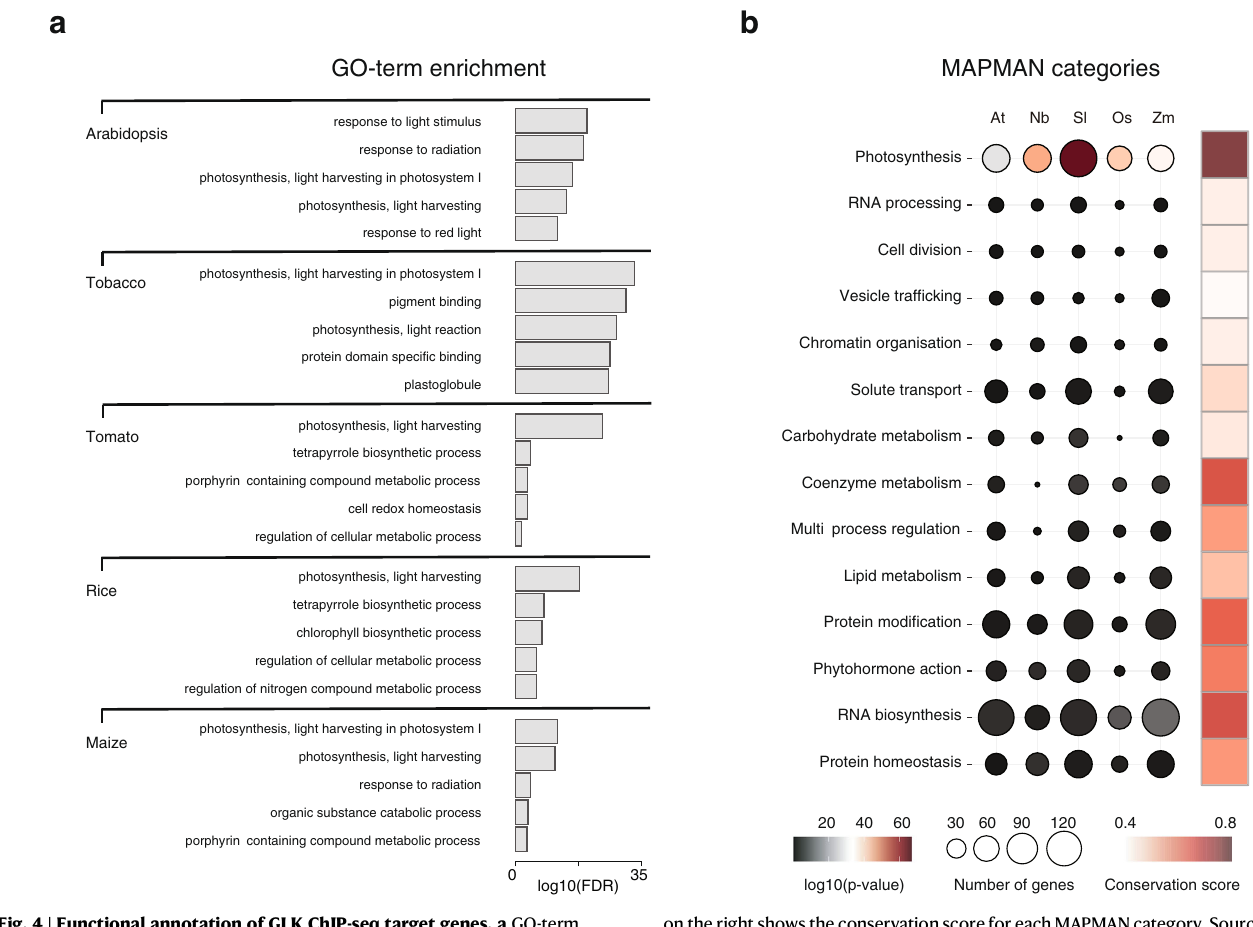
Fig. 4 | Functional annotation of GLK ChIP-seq target genes. a GO-term enrichment analysis of the GLK ChIP-seq target genes in each species. b MAPMAN functional category enrichment analysis (Fisher ’ s exact, two-sided). The